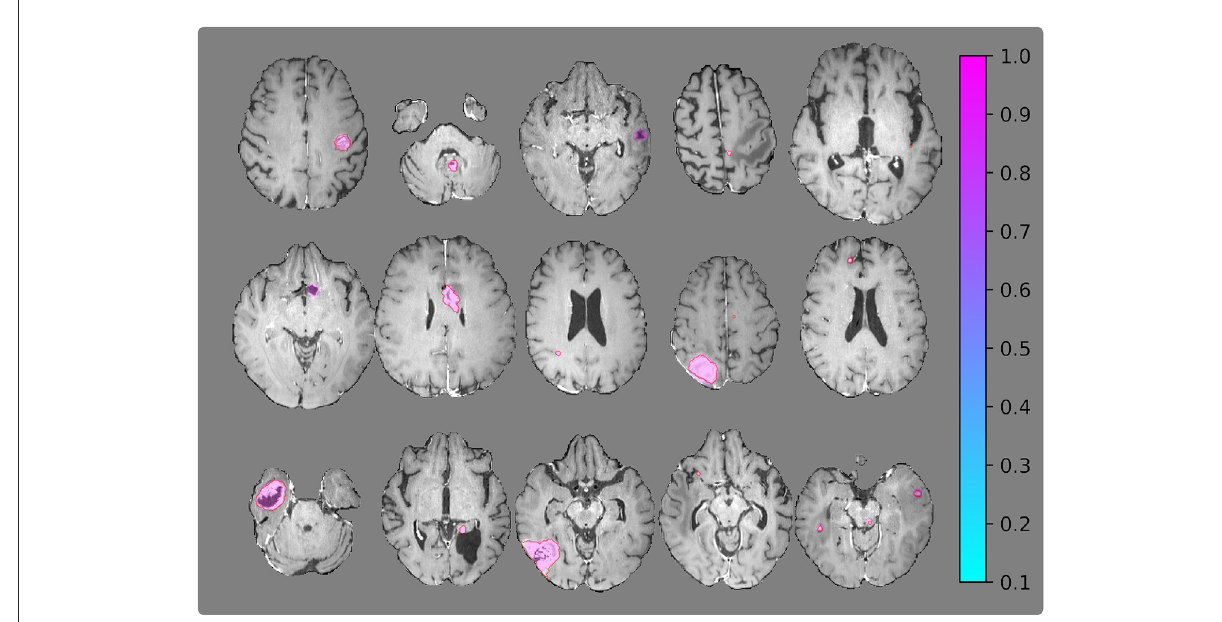
FIGURE7 Visualization of segmentation examples from the OUH cohort with the ground truth annotation (red regions of interests) and the segmentation probability map from the 2.5D